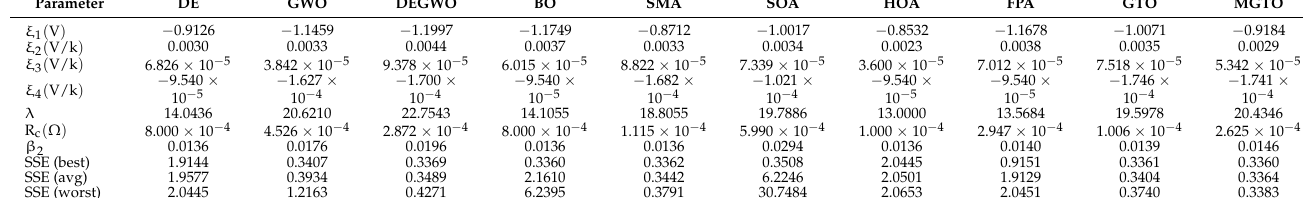
Table 5. Comparison among algorithms on test case 2.